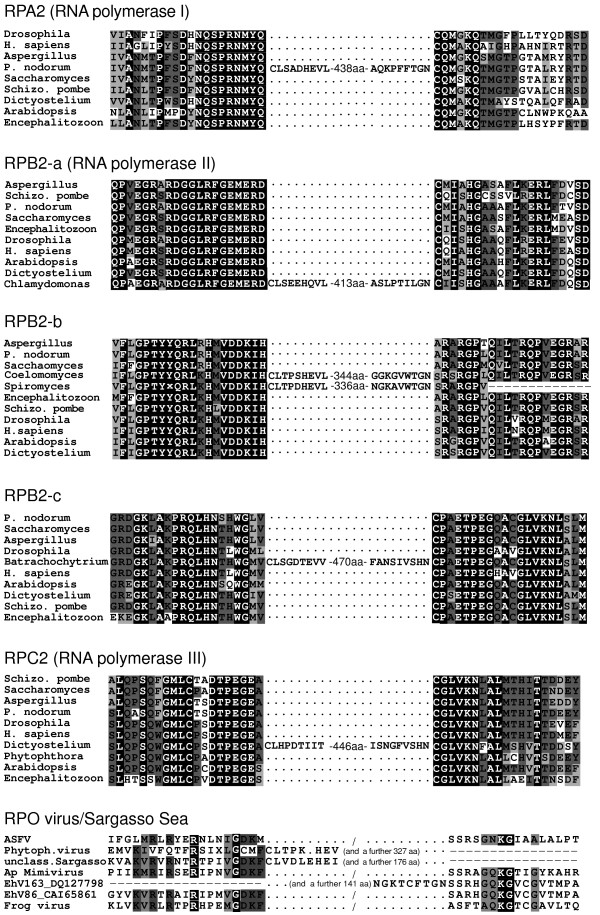
Intein insertions into eukaryotic and viral RNA polymerases. Alignments of intein/extein borders for the eight inteins in the six RNA polymerase intein insertion sites. RNA polymerase sequences are taken from accession data as described in Methods. The unclassified Sargasso Sea sequence is from GenBank accession AACY01369547, the E. huxleyi virus 163 sequence is from GenBank accession (DQ127798). The dashes represent missing data.